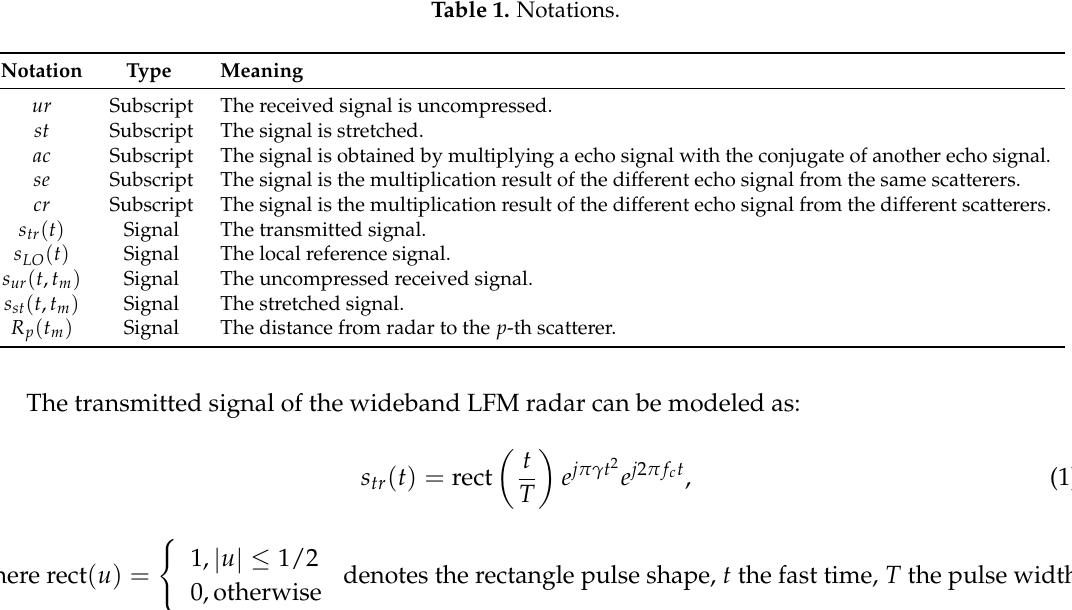
Figure 1. Target’s range profile of wideband radar. Table 1.